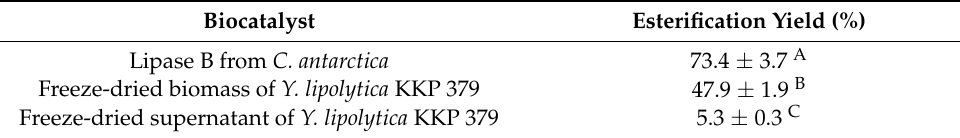
Table 3. The yield of the geranyl 4-hydroxyphenylpropanoate synthesis depending on the biocatalyst used.